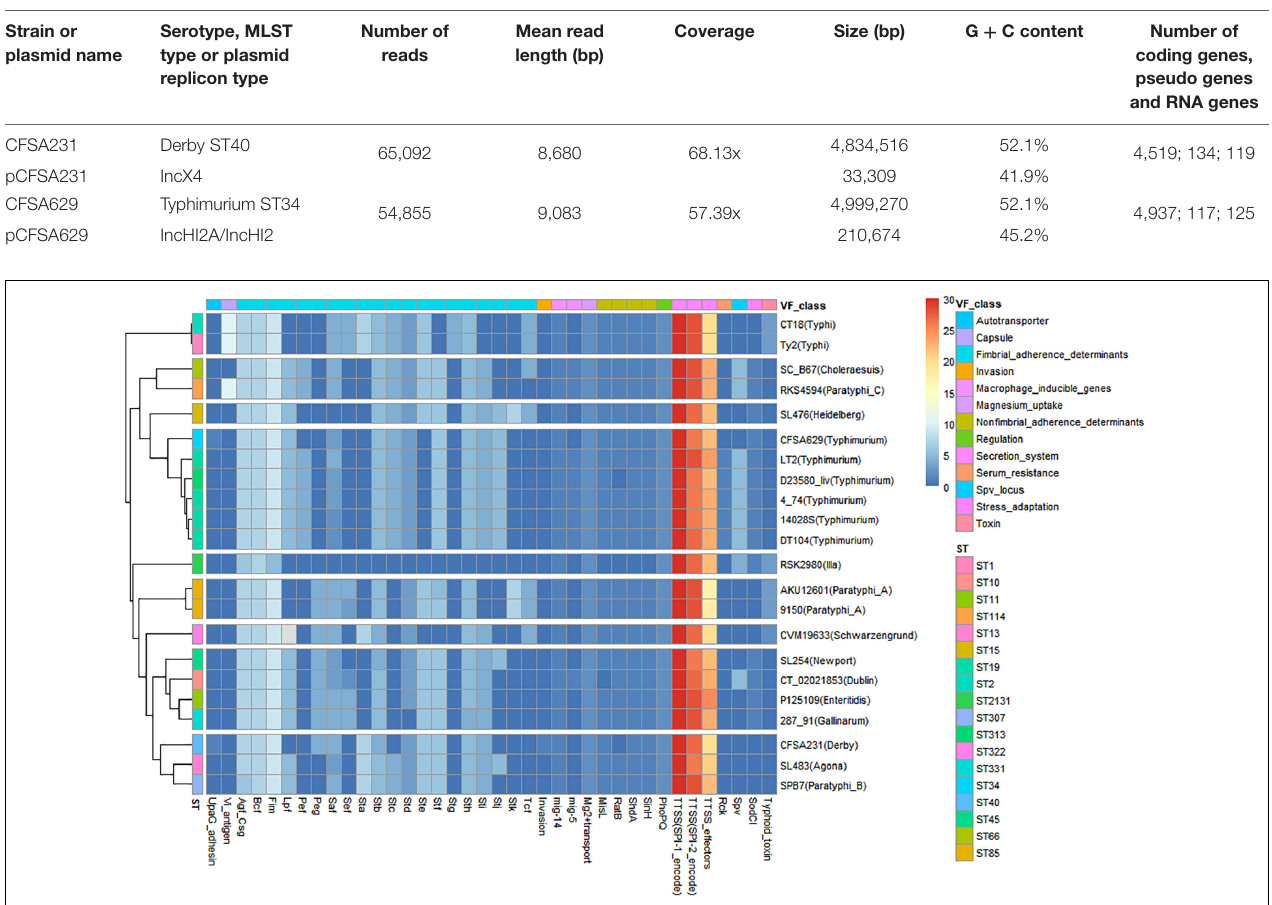
FIGURE 2 | Heatmap showing the relationship of 22 genomes/isolates including Salmonella Derby CFSA231 and Salmonella Typhimurium CFSA629 and 20 reference genomes based on their differential virulence factor classes. Numbers of virulence factors were represented by different colors, high number were marked with red squares (pixels) and low numbers were represented with blue